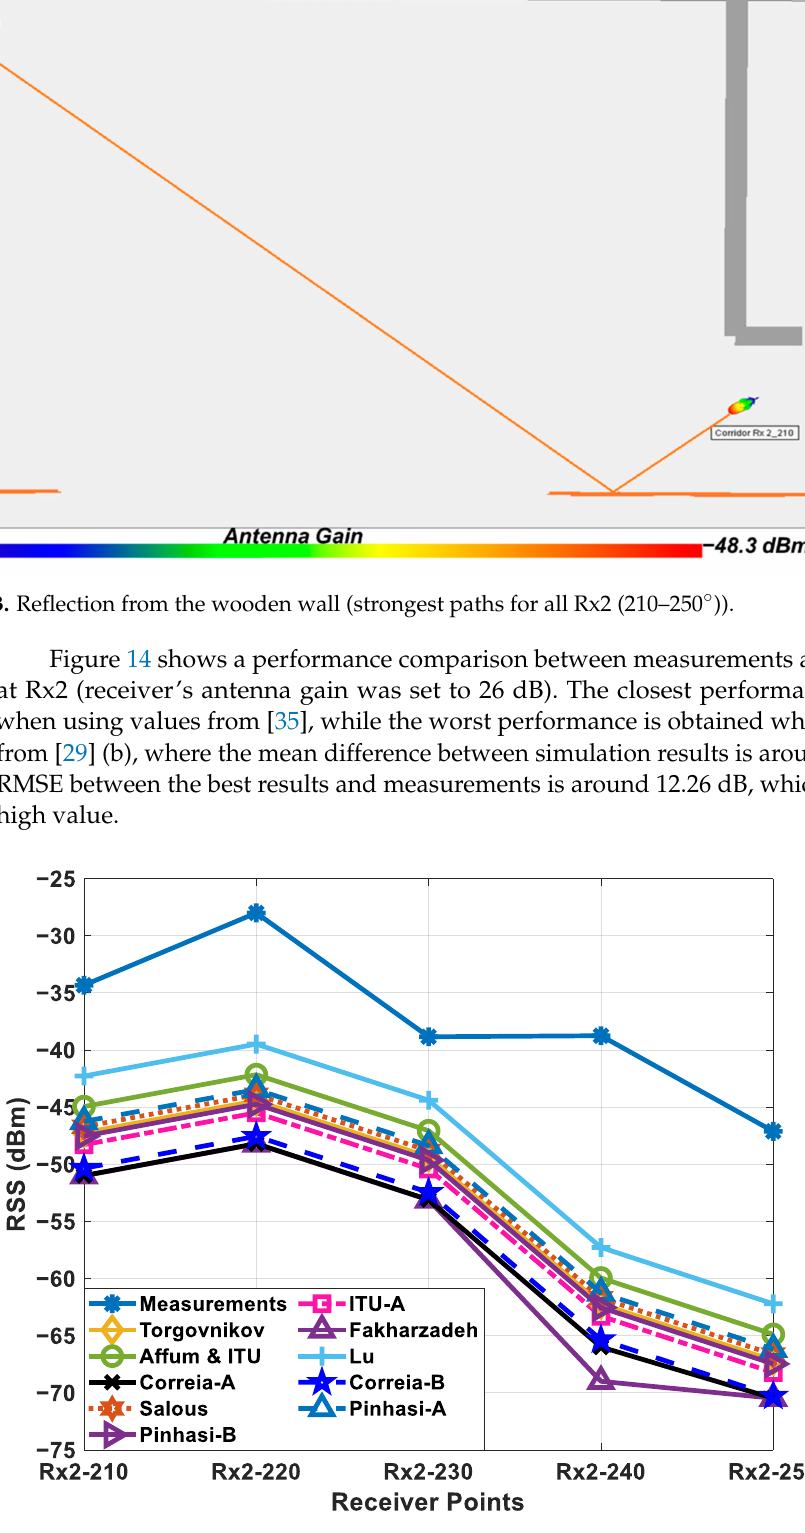
Figure 14. Performance comparison between references at Rx2 (210 – 250°).